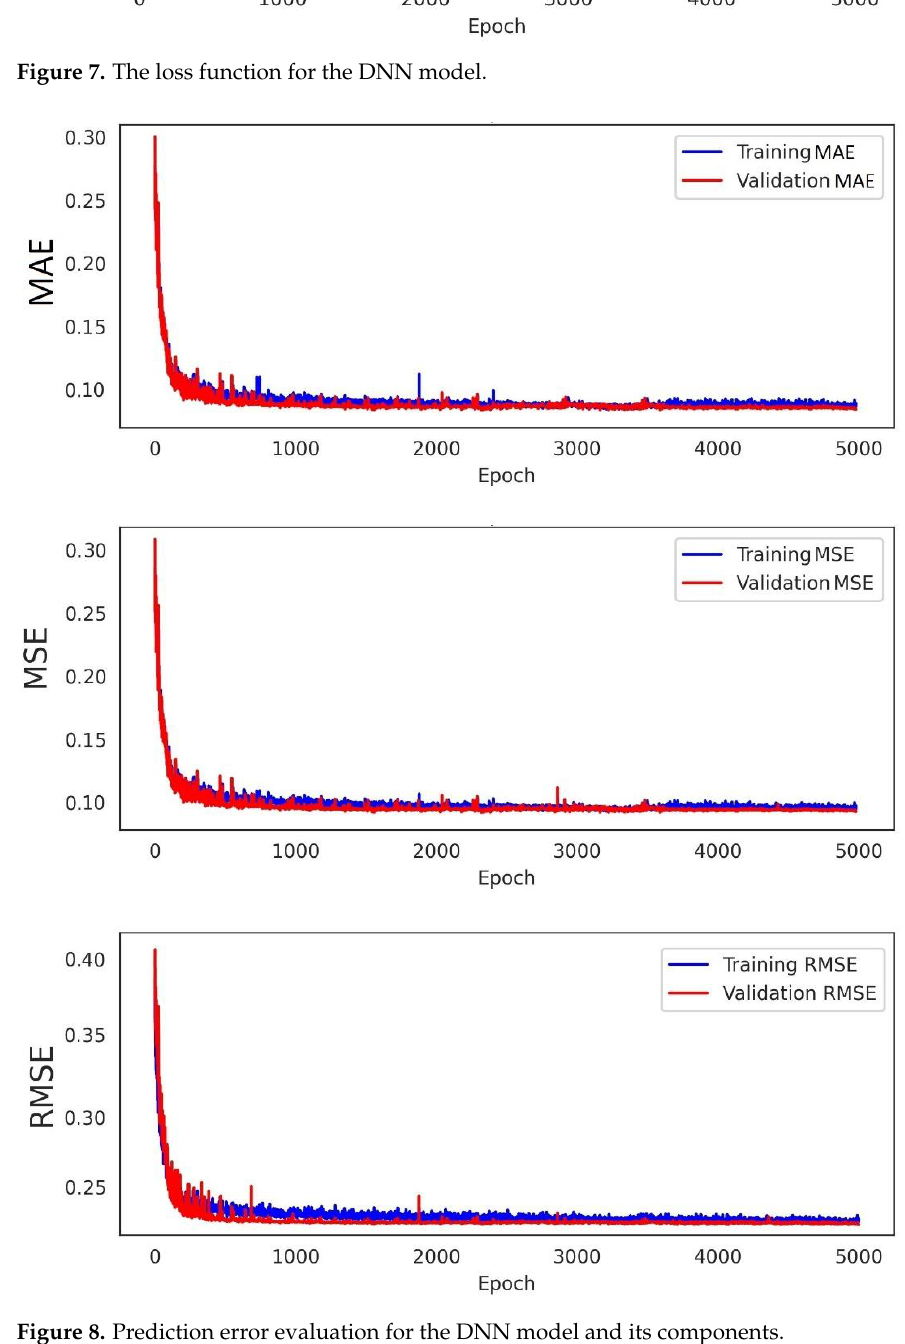
Figure 8. Prediction error evaluation for the DNN model and its components.